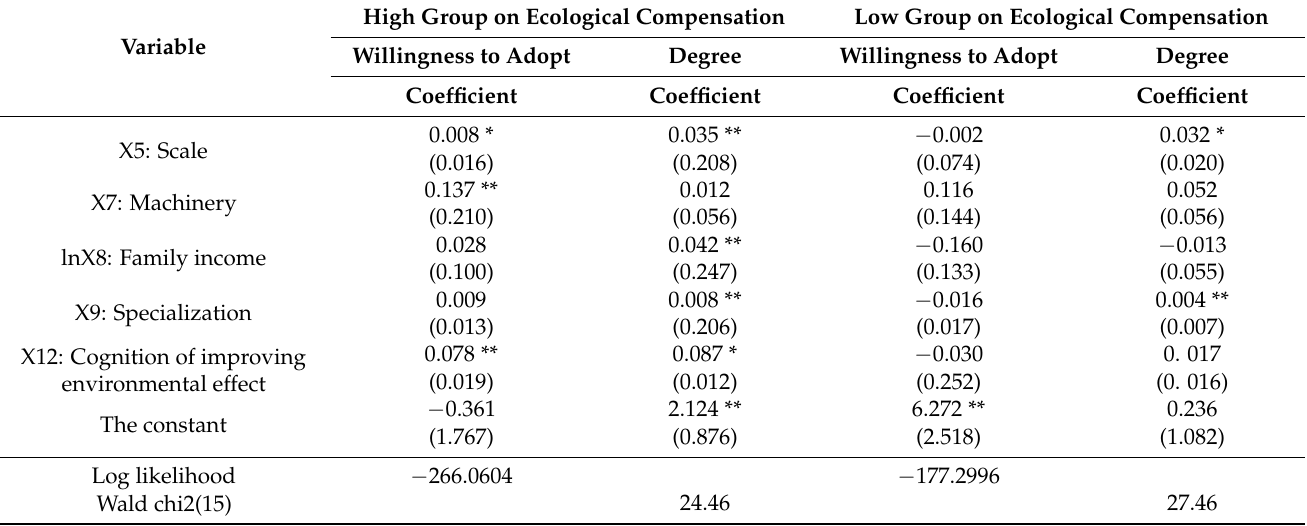
Table 3. Regression results of the robustness